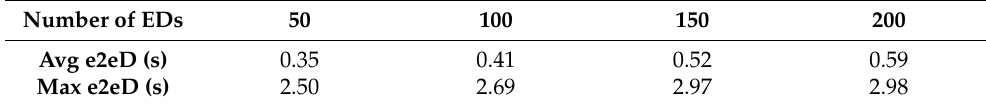
Table 7. Average and maximum e2eD varying the number of EDs.